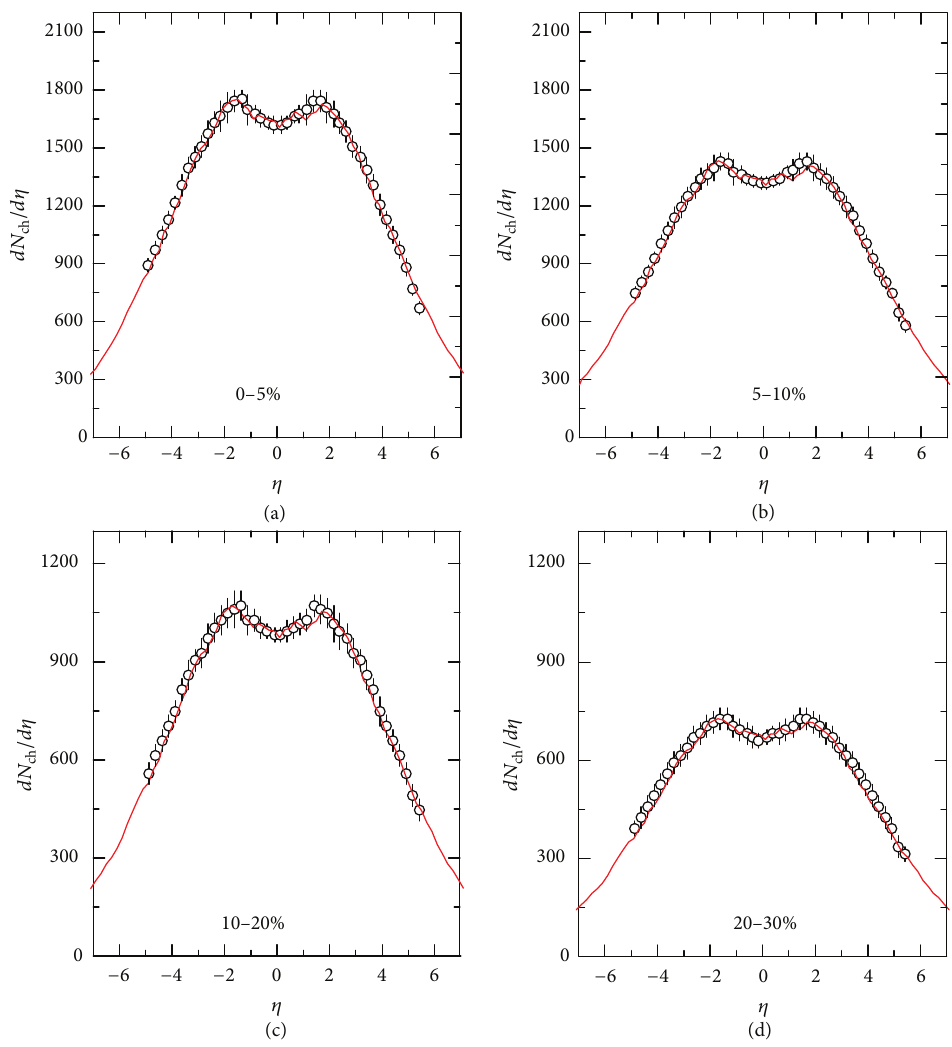
Figure 8: The same as Figure 1 but showing the results of Pb-Pb collisions at √𝑠 NN = 2.76 TeV, where the data are quoted in [26].